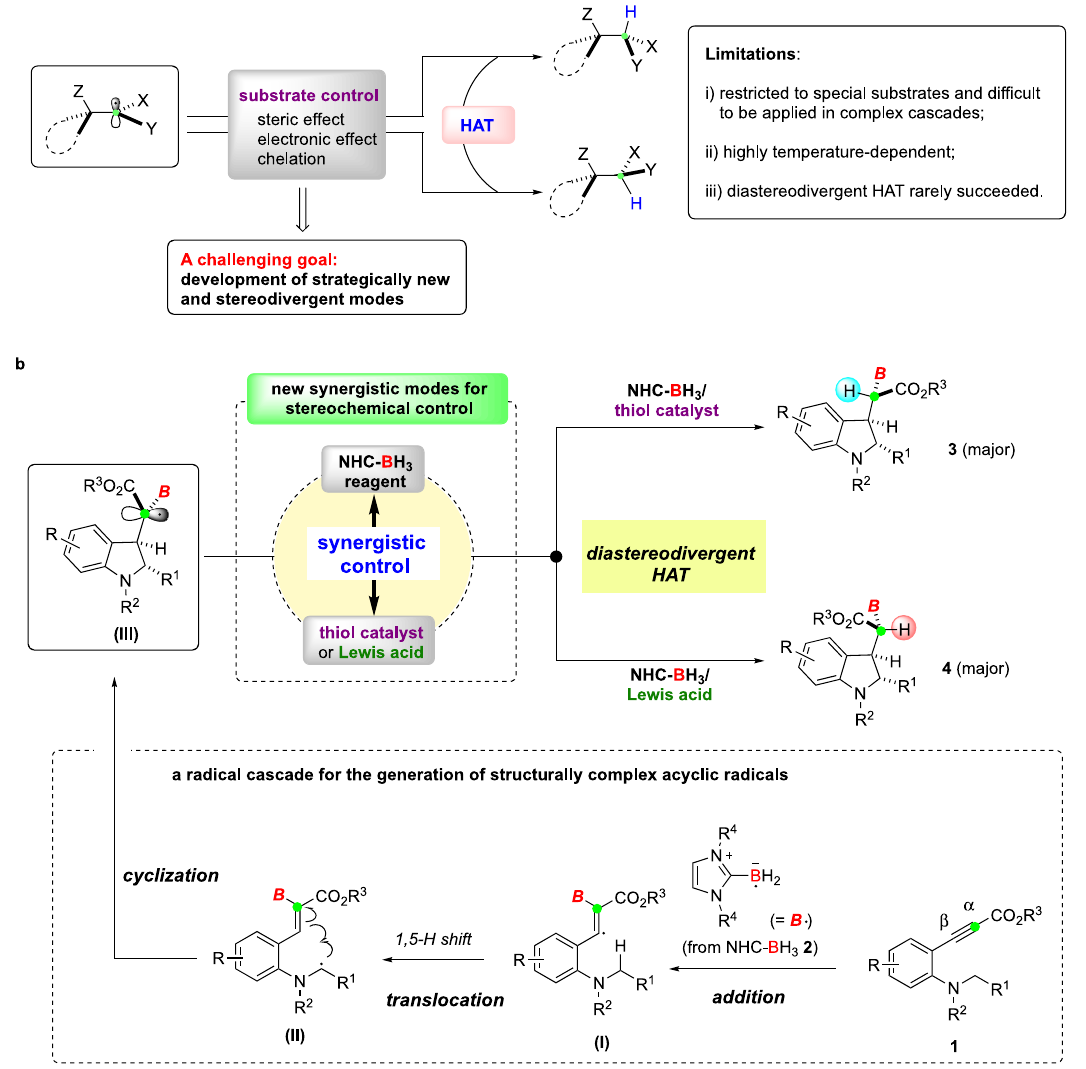
Fig. 1 Diastereoselective HAT to acyclic radicals and the applications in synthesis. a Reported diastereoselective HAT of acyclic radicals methods mainly rely on substrate control. b This work: diastereodivergent HAT of structurally complex radical intermediates synergistically controlled by NHC-BH 3 reagent with either a thiol catalyst or a Lewis acid. NHC N -heterocyclic carbene, HAT hydrogen atom